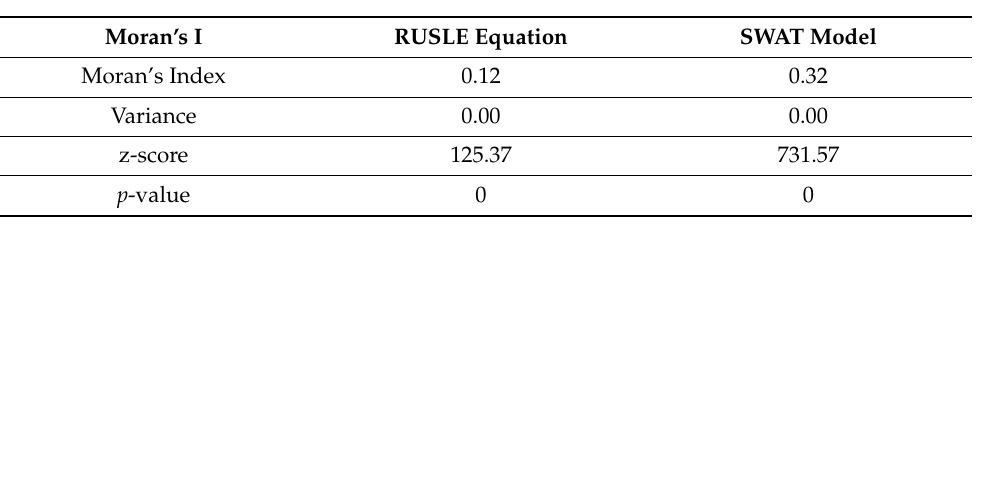
Table 10. Result of Moran’s I